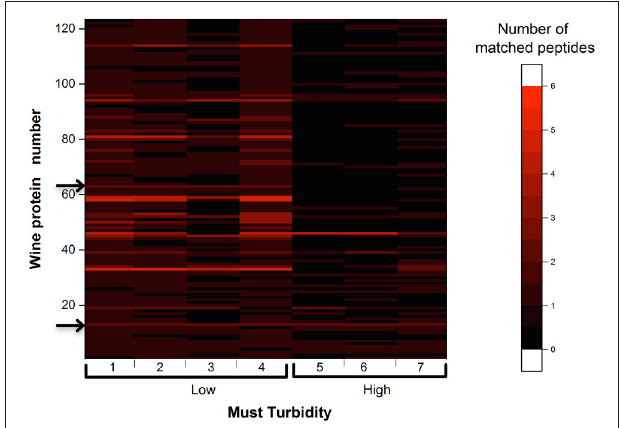
FIGURE 2 | Heat map representing the number of matched peptides among the 123 wine proteins found in Chardonnay white wines elaborated from low turbidity (Low) and high turbidity (High) musts for the vintage 2010. One of the four wines, obtained from a high turbidity must, used in the experimentation has been discarded due to the lowest presence of wine proteins, and peptide retention time alignment problems. Arrows on the left indicate proteins N ◦ 14 and 63.